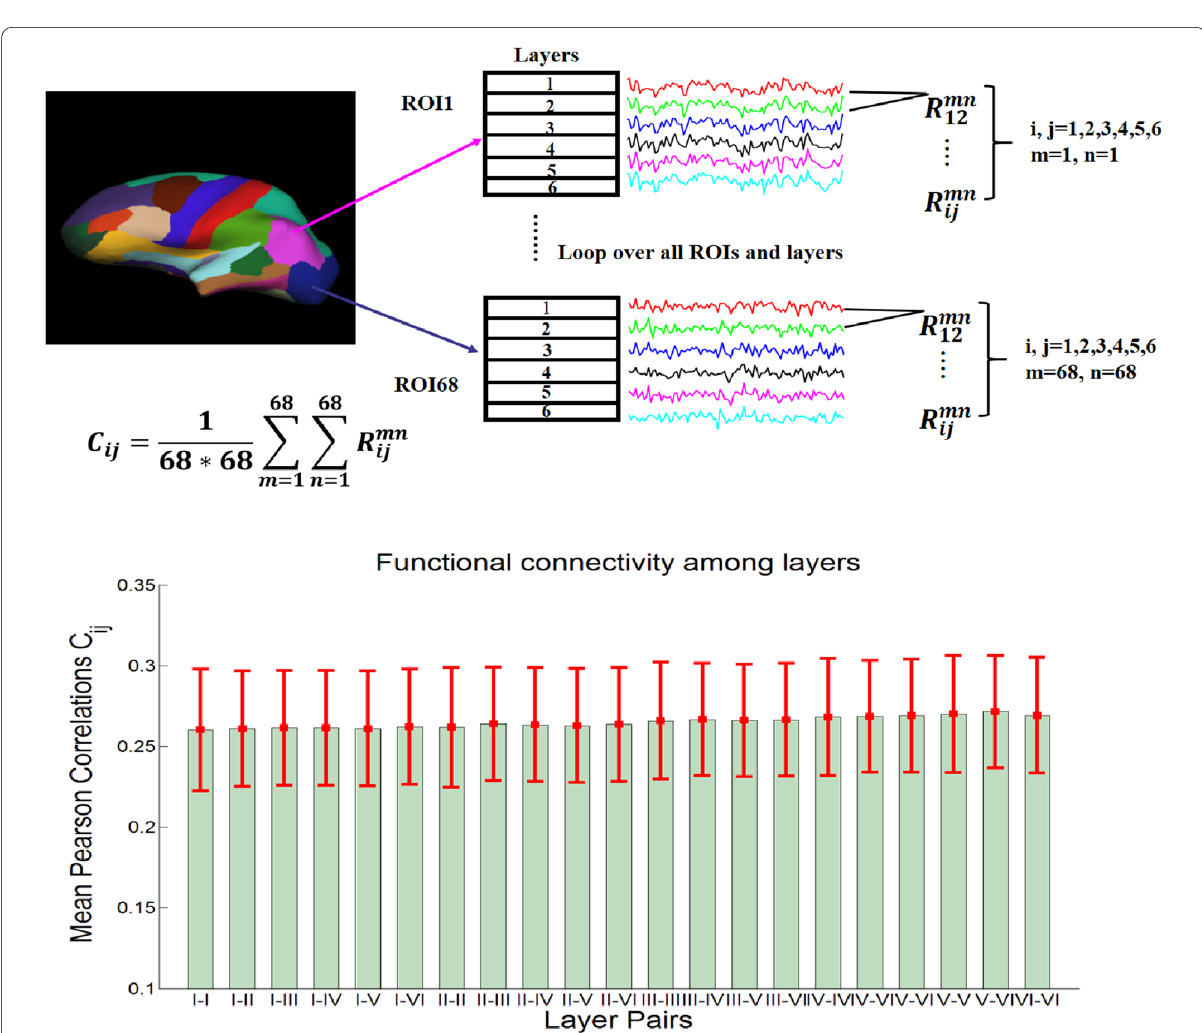
Fig. 3 Top: an illustration of the method for calculating FC between all layers across all cortical regions to investigate global trends ( i , j represents layer number; m , n represents regions, and C ij represents the mean Pearson’s correlation between two given layers calculated across all cortical regions). Bottom: the mean Pearson’s correlation values between a given layer and all layers across all cortical regions in the Desikan–Killiany [9] atlas. No significant differences were found. 21 pairs are included. The error bar indicates the calculated standard